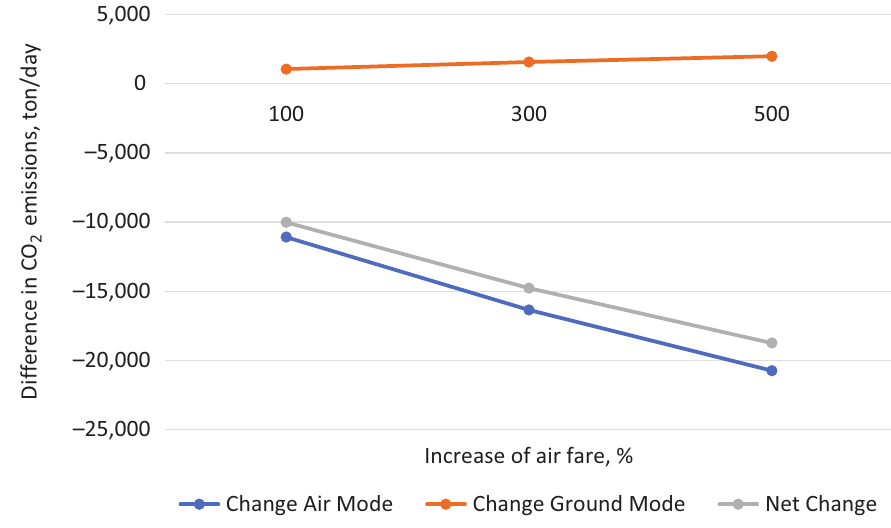
Figure 4. Change in CO